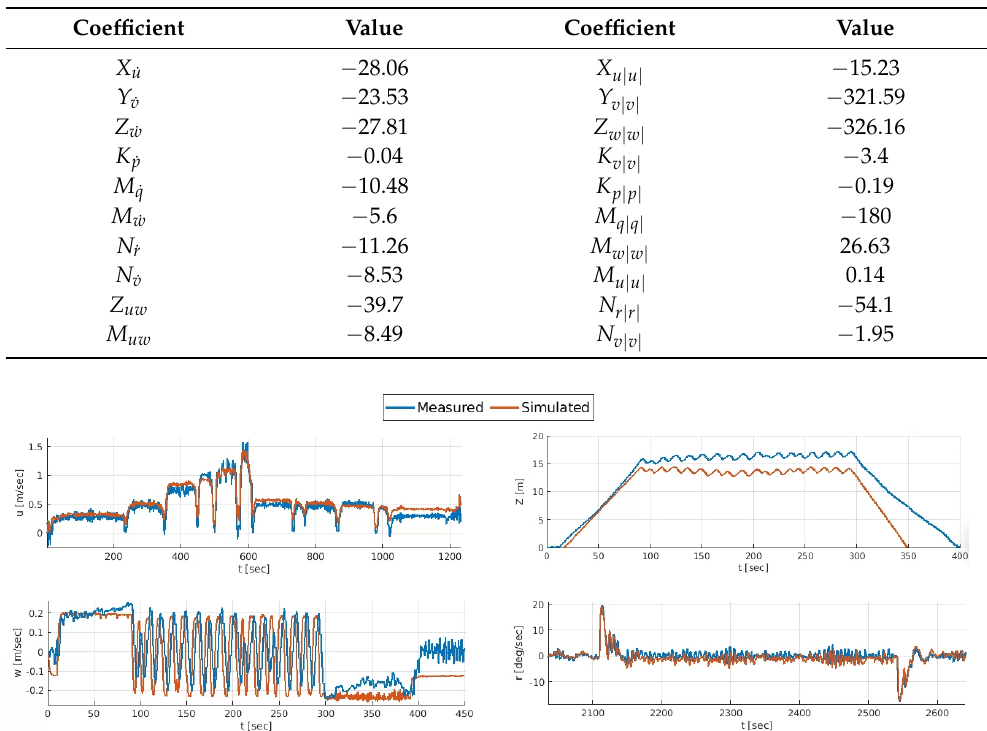
Figure 7. Model calibration results for surge ( top left ), heave ( bottom left ), depth ( top right ) and yaw rate ( bottom right ) as determined by the experiments.